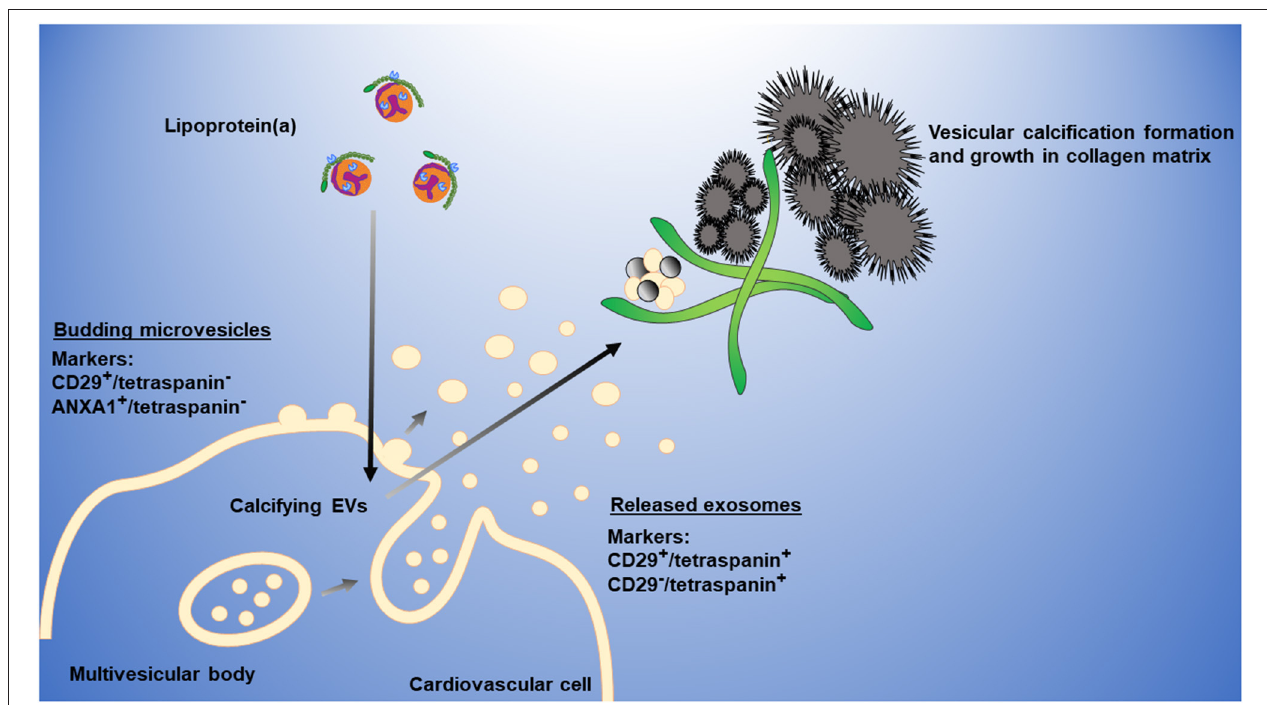
FIGURE 6 | Working model of Lp(a) induction of cardiovascular calcification via EVs. Lp(a) is taken up by cardiovascular cells, stimulating increased release of annexin-enriched calcifying EVs, particularly microvesicles (CD29 + /tetraspanin − EVs) that get trapped in collagen extracellular matrix, aggregate, and form microcalcification that coalesces into larger macrocalcification. Plasma membrane microvesicles can largely be distinguished from multi-vesicular body-derived exosomes through the presence of markers, including CD29 or ANXA1, and the absence of tetraspanins, including CD63 that is enriched on